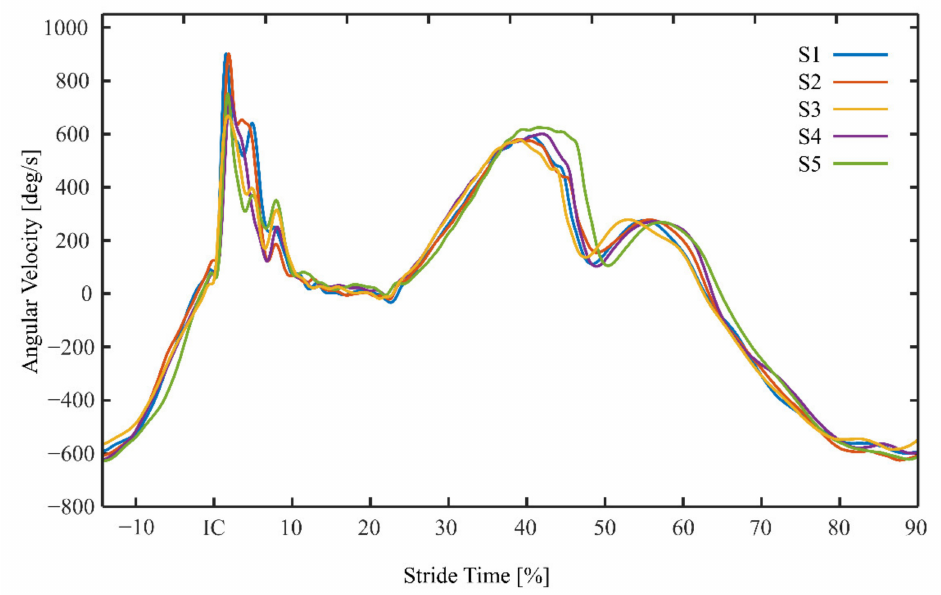
Figure 3. Exemplary curve of the angular velocity for one subject during one stride cycle. Determina- tion of peak angular velocity within the first 20% of stride cycle time after initial ground contact of the foot